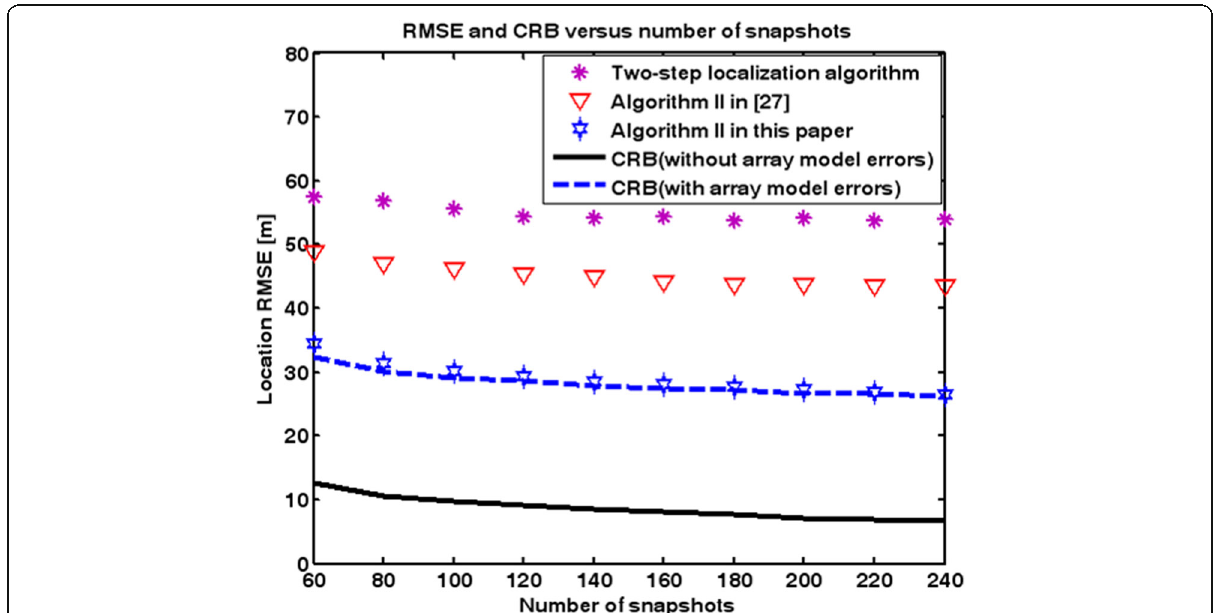
Fig. 8 RMSEs of localization methods and the corresponding CRBs as a function of number of snapshots for case of known signal waveform